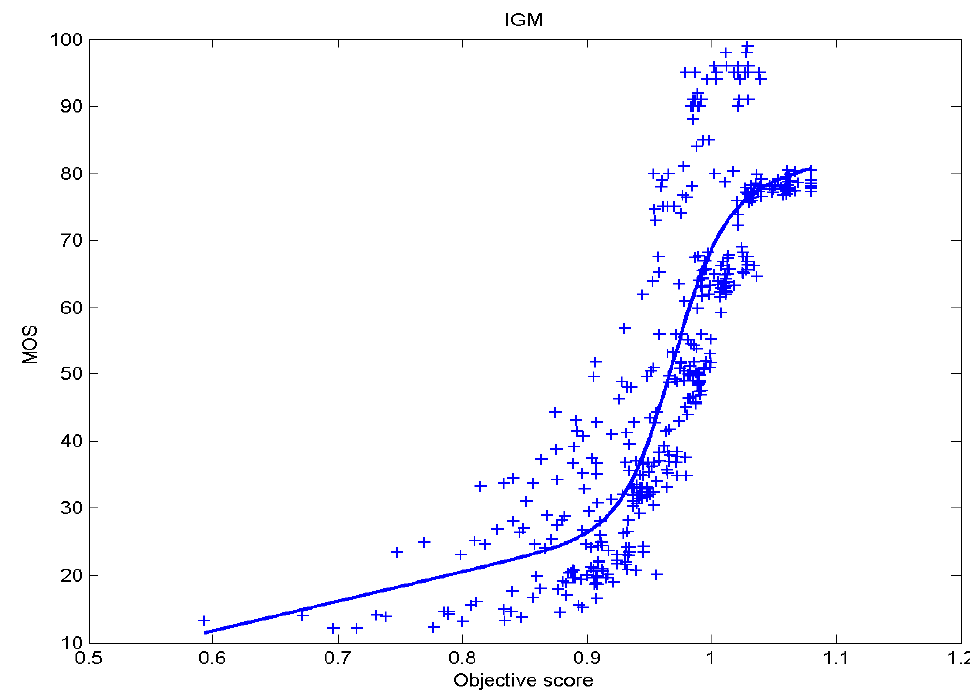
Figure 14. Scatter plots of the subjective scores (MOS) vs. IGM.